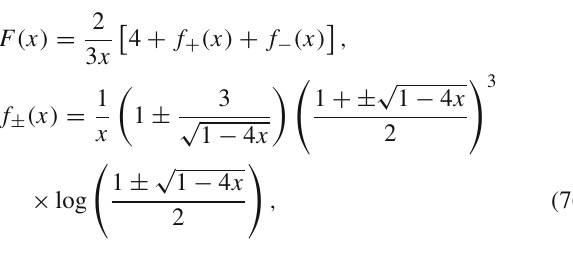
Fig. 19 Summary of constraints from the phenomenology of a fermionicDMinthecaseofs-channelpseudoscalarmediator.Theseare reported in the bi-dimensional ( m a , m ψ ) plane for the three assigna- tions of (λ a ψ , c a ) parameters, namely, ( 1 , 0 . 25 ) (left), ( 1 , 1 ) (middle) and ( 0 . 25 , 1 ) (right). The red lines are the iso-contours of the correct DM relic density. In the yellow regions the DM annihilation cross- section into SM fermions, computed at the present time, exceeds the